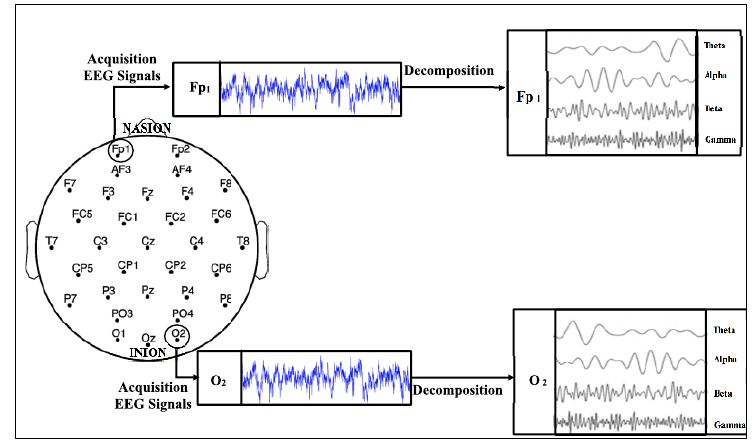
Figure 3. The decomposition process of EEG signals in one experiment (sixty